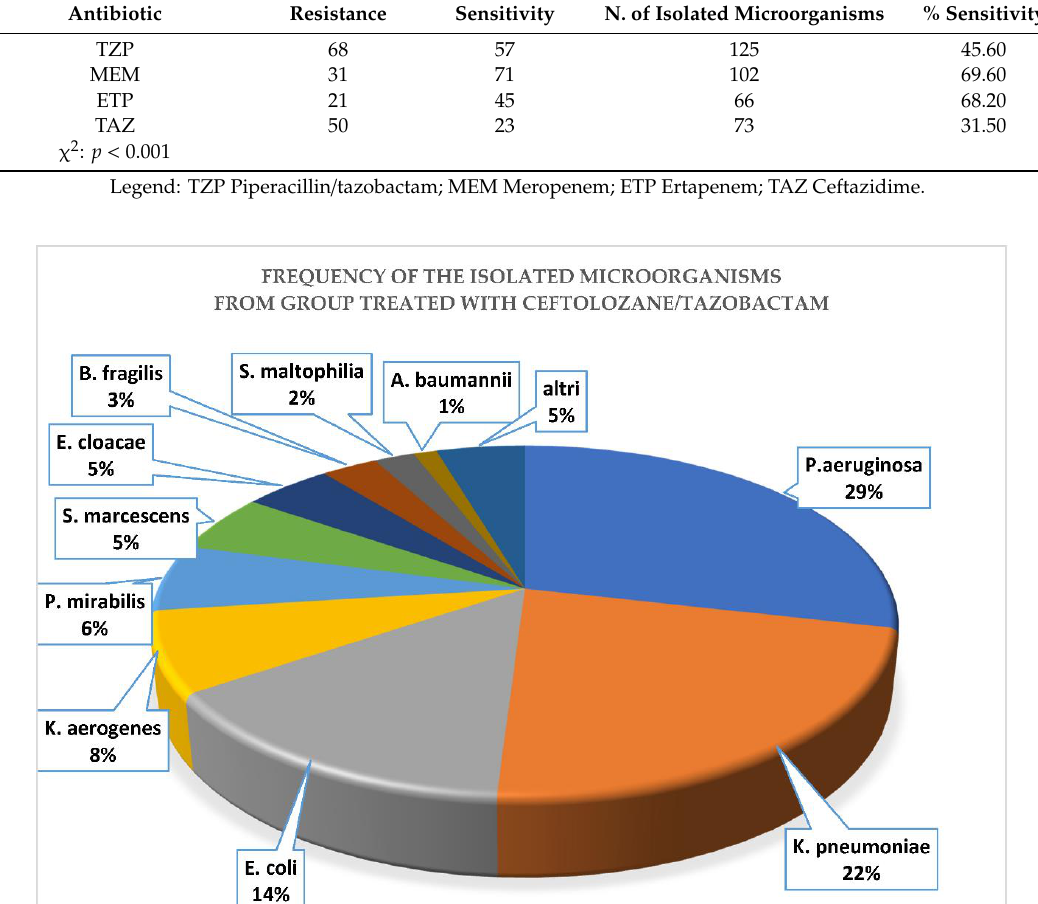
Figure A2. Frequency of the isolated microorganisms from group treated with ceftazidime/avibactam.